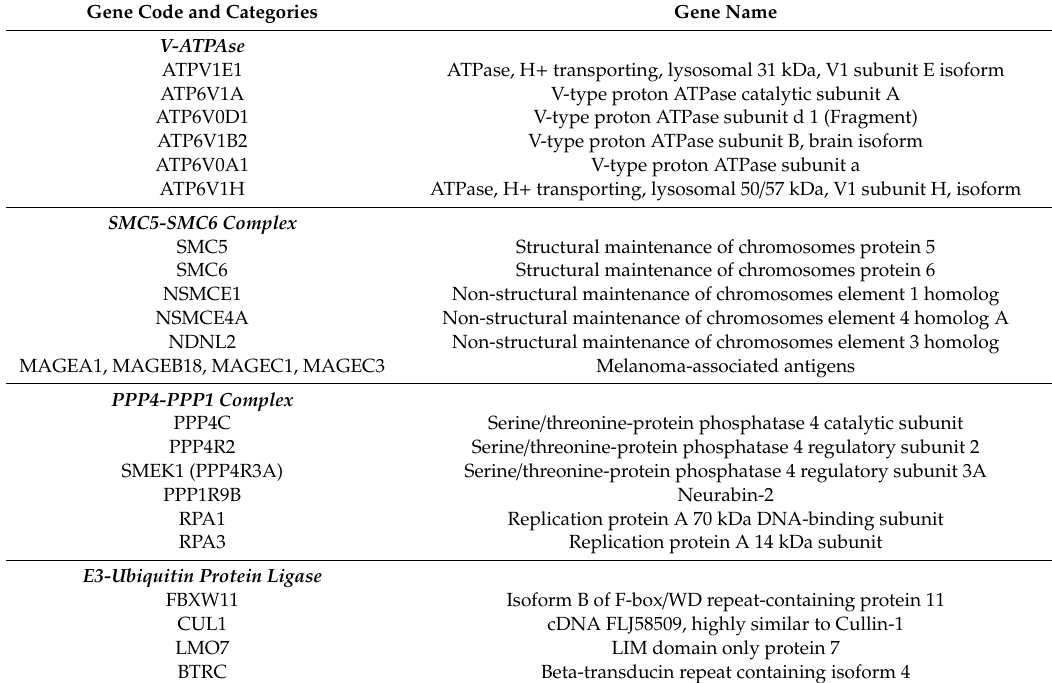
Figure 6. Analysis of the common host tumor antigen interacting proteins using “STRING database”. Both JCV LT-Ag and Sm t-Ag also target common host proteins including actin-myosin network, ribosomal / RNA binding proteins, and others (Table 5). Table 3. Host proteins that interact with JCV